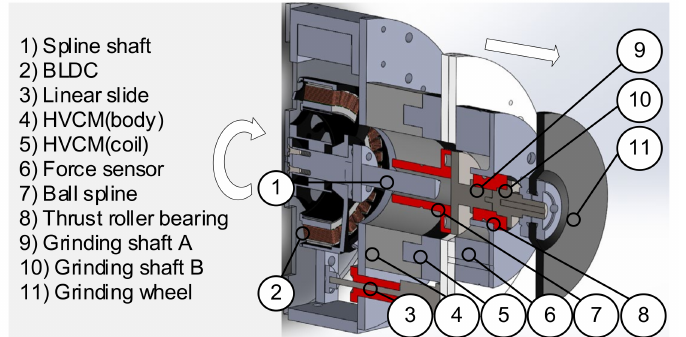
Figure 1. Section view of the CAD drawing of the designed grinding